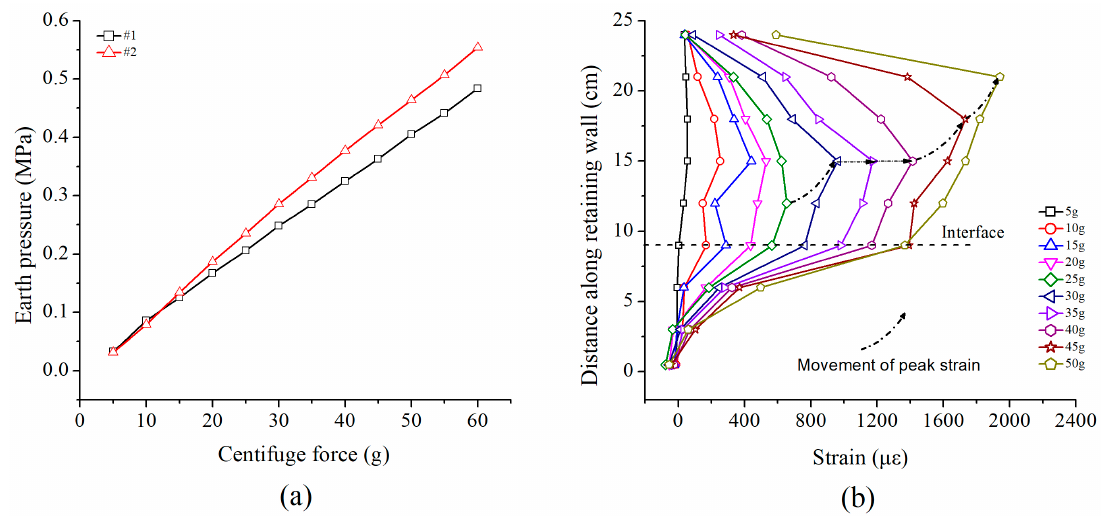
Figure 11. Test result of earth pressure and retaining wall. ( a ) Earth pressures ( b ) Strain curves of retaining walls.